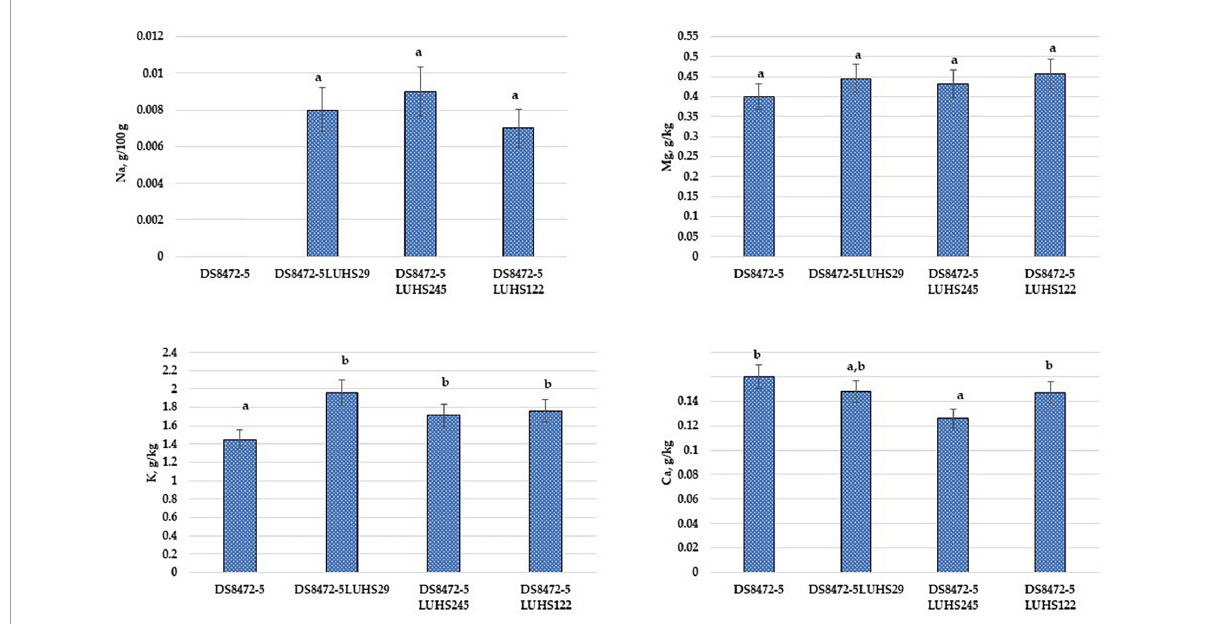
FIGURE4 Macro-element concentrations in wheat cereal wholemeal (WCW) (DS8472-5) samples. LUHS29, treated with Pediococcus acidilactici ; LUHS245, treated with Liquorilactobacillus uvarum ; LUHS122, treated with Lactiplantibacillus plantarum LUHS122. Results presented as the mean ( n = 3) ± SE. a , b Means with different letters in column are significantly different ( p ≤